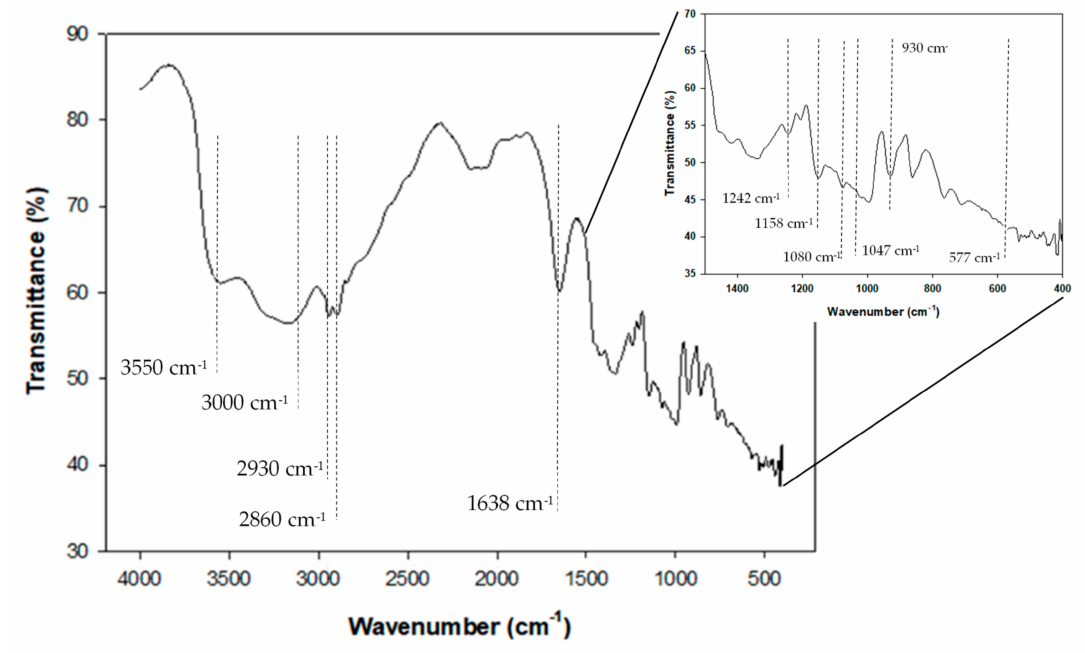
Figure 5. FT-IR spectra of Ceiba aesculifolia subsp. parvifolia tuber